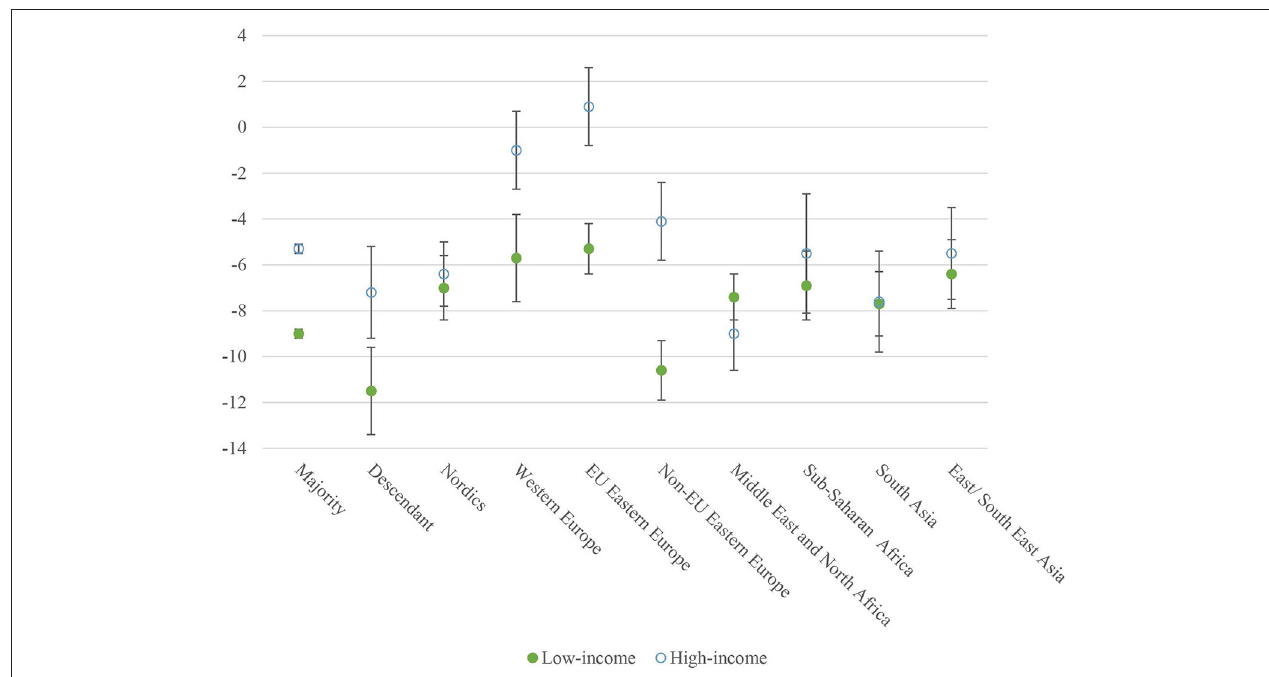
FIGURE 2 | The interaction effect of OPMH service use on income by region of origin and income distribution. Adjusted for age, educational level, marital status, motherhood, and time fixed